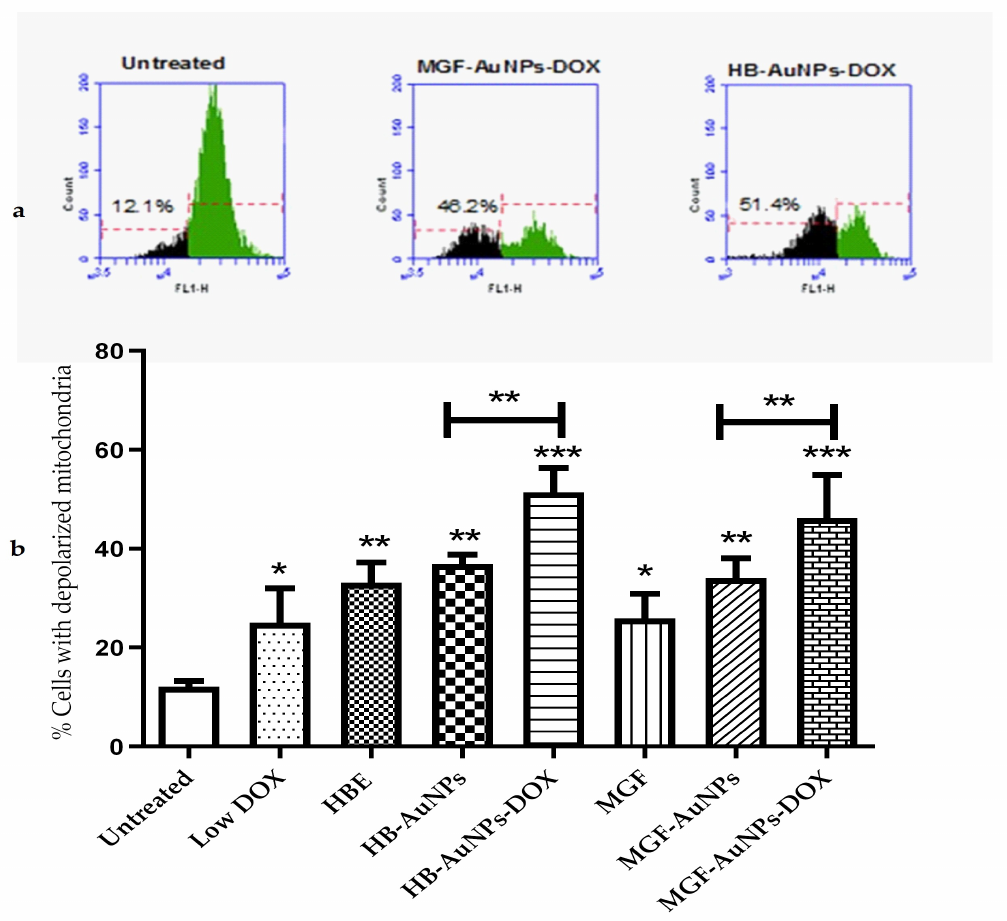
Figure 4. Effect of treatments on mitochondrial function. Caco-2 cells were treated with Low DOX (1.56 µ g/mL), MGF (1000 µ g/mL), HBE (1000 µ g/mL), MGF-AuNPs (1000 µ g/mL), HB-AuNPs (1000 µ g/mL), MGF-AuNPs-DOX (1000 µ g/mL MGF-AuNPs and 1.56 µ g/mL DOX) and HB-AuNPs-DOX (1000 µ g/mL HB-AuNPs and 1.56 µ g/mL DOX). Mitochondrial membrane potential was assessed using a TMRE probe and flow cytometry. ( a ) shows the histograms of the relative fluorescence of cells left untreated, cells treated with MGF-AuNPs-DOX and HB-AuNPs-DOX; green indicates the cell population with normal mitochondrial membrane potential, and black indicates the cell population with reduced mitochondrial membrane potential; indicated on the histograms are the percentage of cells with depolarized mitochondria. ( b ) shows a bar graph, which summarizes the results for all the treatments. Results are expressed as mean ± standard error of the mean (SEM). Data were considered statistically significant if p < 0.05, *** p < 0.001, ** p < 0.01, * p < 0.05. The cytotoxic assays used in this study indicated that treatment with a combination of biogenic AuNPs and DOX induced cell death in Caco-2 cells. Therefore, some of the hallmarks of apoptosis, i.e., the externalization of the phosphatidyl serine (using the APO Percentage assay) and the DNA fragmentation (using the APO-DIRECT TM assay) were also assessed. The APO Percentage assay uses a fluorescein dye (TCTF) that becomes trapped within apoptotic cells that are undergoing phosphatidyl serine (PS) externalization and cell membrane blebbing [29] PS is predominantly found in the inner cell membrane but translocates to the outer membrane during apoptosis. PS externalization and cell membrane blebbing are indicators or hallmarks of apoptosis [30]. The APO Percentage assay and APO-DIRECT TM assay were performed to evaluate the induction of apoptosis following